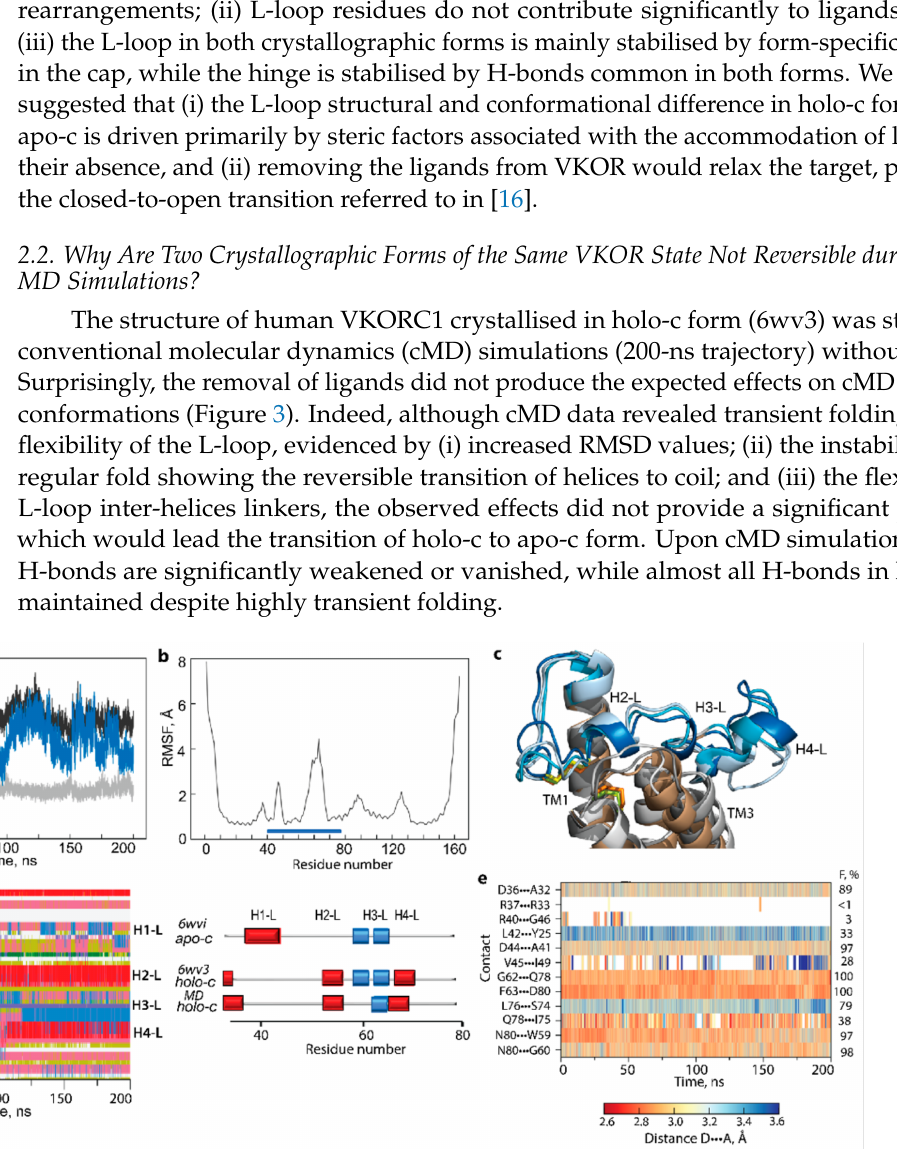
Figure 3. Analysis of cMD simulation of VKOR holo-c form without warfarin. (a) RMSDs from initial coordinates computed for the whole protein C α -atoms (black), TMD (grey), and L-loop (blue) after fitting on the crystallographic structure-related domain. ( b ) RMSFs computed for C α - atoms after fitting on the crystallographic structure. Blue horizontal bar delimits L-loop residues. ( c ) Superimposition of L-loop conformations randomly picked at t = 165 and 200 ns on crystallographic structure (6wv3). Protein is shown as cartoon with disulfide bridges as sticks. VKOR conformations and their structural elements are distinguished by colour: TMD helices, L-loop, and disulfide bridges in sand, dark blue, and yellow (6wv3); in dark grey, sky blue, and lemon (cMD frame picked at t = 165 ns); and in light grey, light blue, and orange (cMD frame picked at t = 200 ns). ( d ) (Left) Time-dependent evolution of each residue secondary structures as assigned by the Define Secondary Structure of Proteins (DSSP) method for L-loop: α -helices are in red, 3 10 -helices in blue, turn in orange, and bend in dark yellow. (Right) Interpretation of L-loop secondary structures in two crystallographic forms (two first lines) and for the average MD conformation (third line) of holo-c form. α - and 3 10 -helices are shown in red and blue, respectively, and numbered as in [15]. ( e ) Frequency (F, %) and length of H-bonds observed upon cMD simulation of holo-c